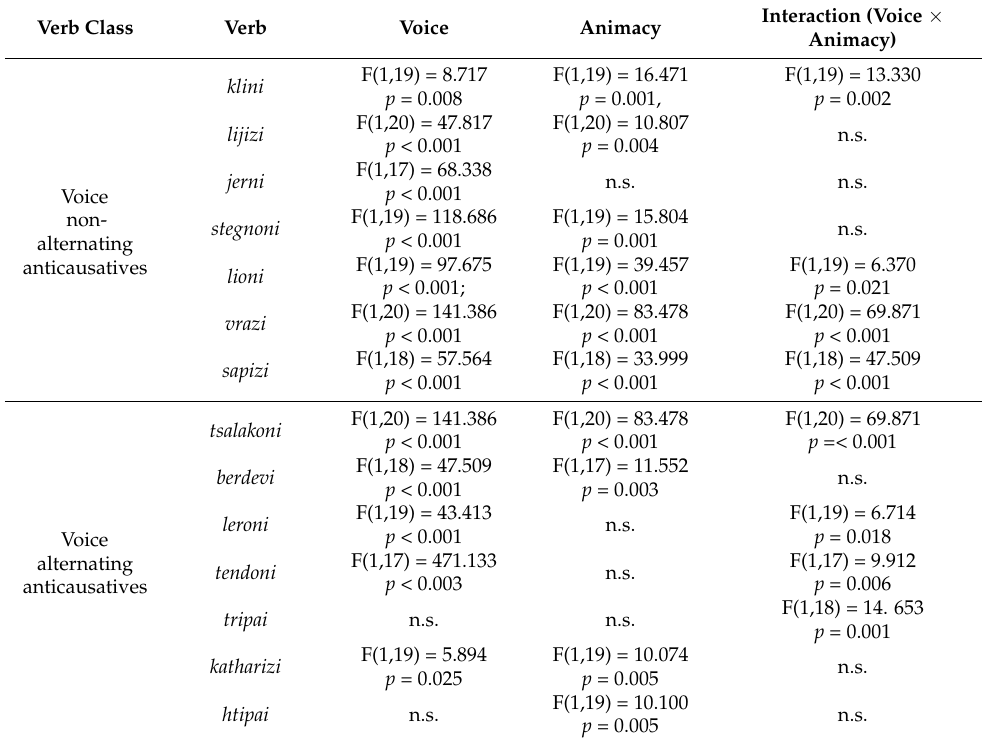
Table 5. Main effects (voice, animacy) and their interaction, across verbs’ degree of acceptability. Verb Class Verb Voice Animacy